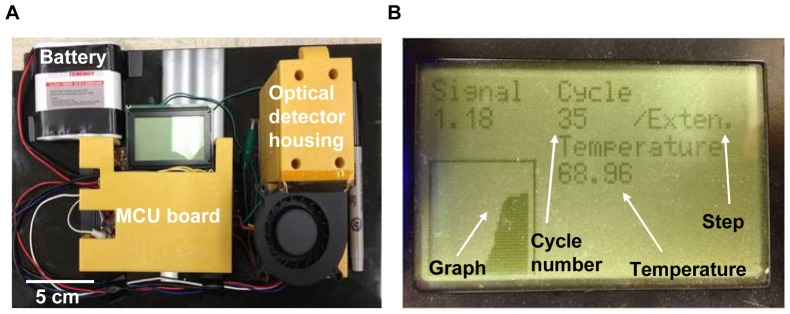
Photograph of the portable real-time microchip PCR system.(A) The portable real-time microchip PCR system controlled by an MCU and powered by a battery. The entire size is 16×28×9 cm3, and the total weight is 843 g. (B) The LCD of the MCU board displays several information about the real time PCR such as the number of cycle, current PCR step, current temperature, fluorescence intensity, the increasing amount of the present cycle’s fluorescence intensity compared to the first cycle’s fluorescence intensity, and the graph showing the trace of the fluorescence intensity of each cycle.